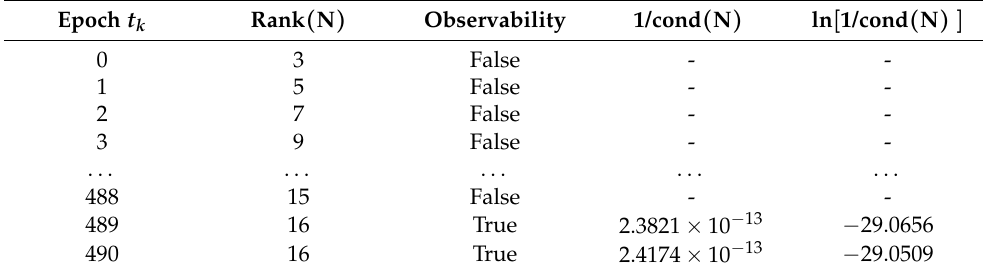
Table 4. Observability test results of case III (with J 2 , J 3 , and J 4 perturbations). Epoch t k